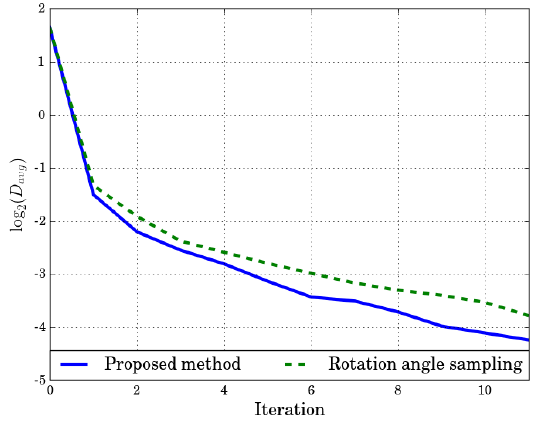
Figure 3: The averaged log Kullback-Leibler divergence from 100 simulations.